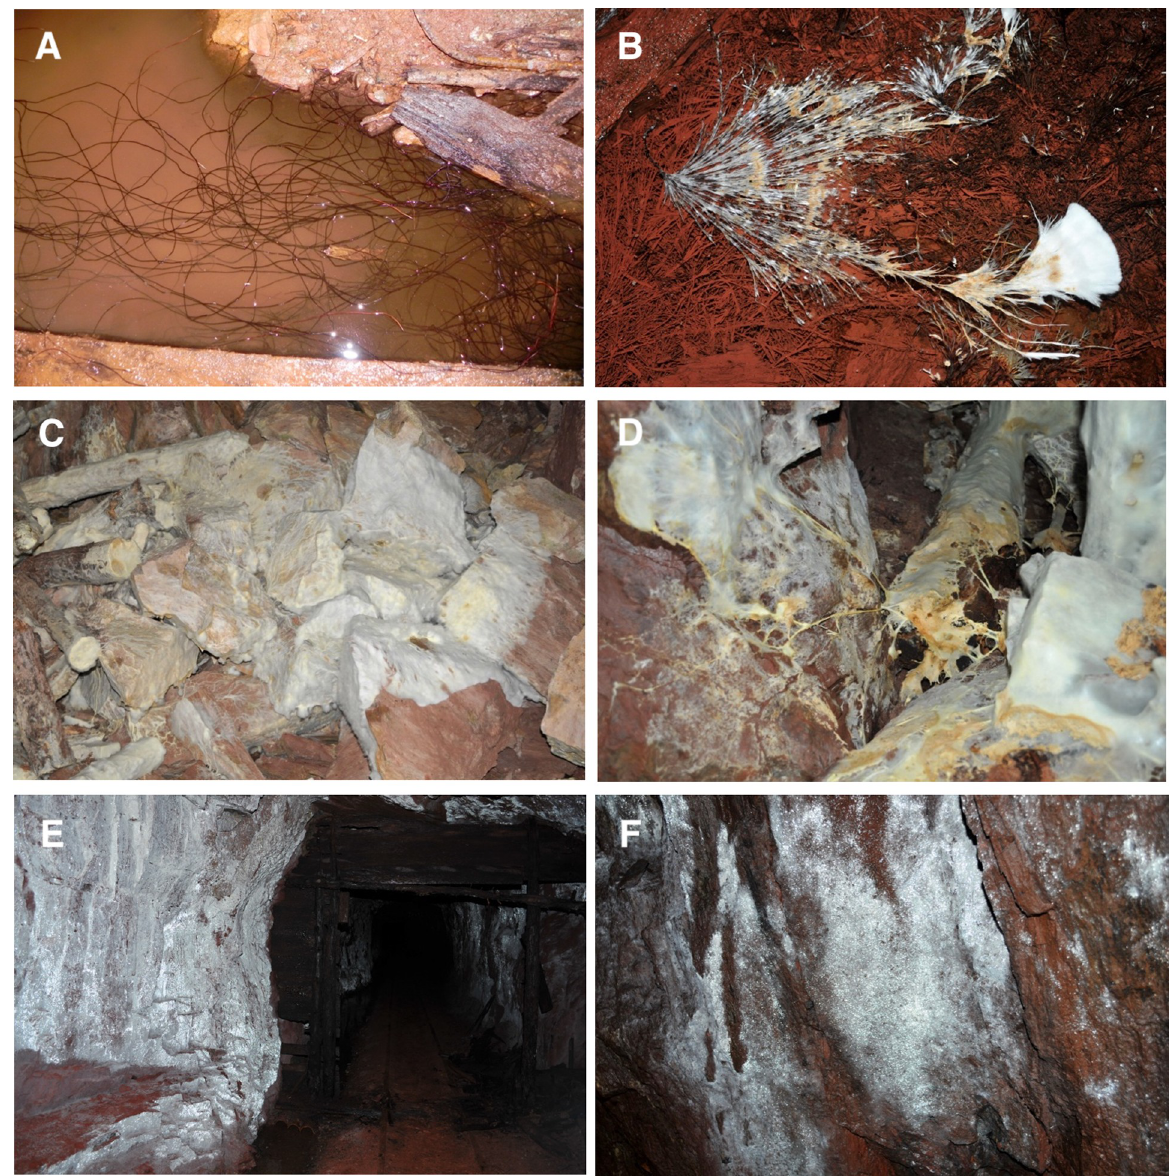
Fig 1. Images of unusual fungal growth in the Soudan mine. (A) masses of rhizomorphs of Armillaria sinapina growing on logs and in a water pool. (B) fresh mycelial growth of A . sinapina on the surface of a water pool with large amounts of rhizomorphs on the bottom of the pool heavily laden with iron and other metals. (C) large area of fungal mycelium of Postia sp. growing from wood material over rock surfaces. (D) Postia sp. forming rhizomorphs from wood growth enabling it to transport nutrient to the advancing front as it grows across rock surfaces. (E) growth of Pseudogymnoascus sp. over large areas of wall and ceiling. (F) Pseudogymnoascus sp. growing on the rock surface of the mine wall.